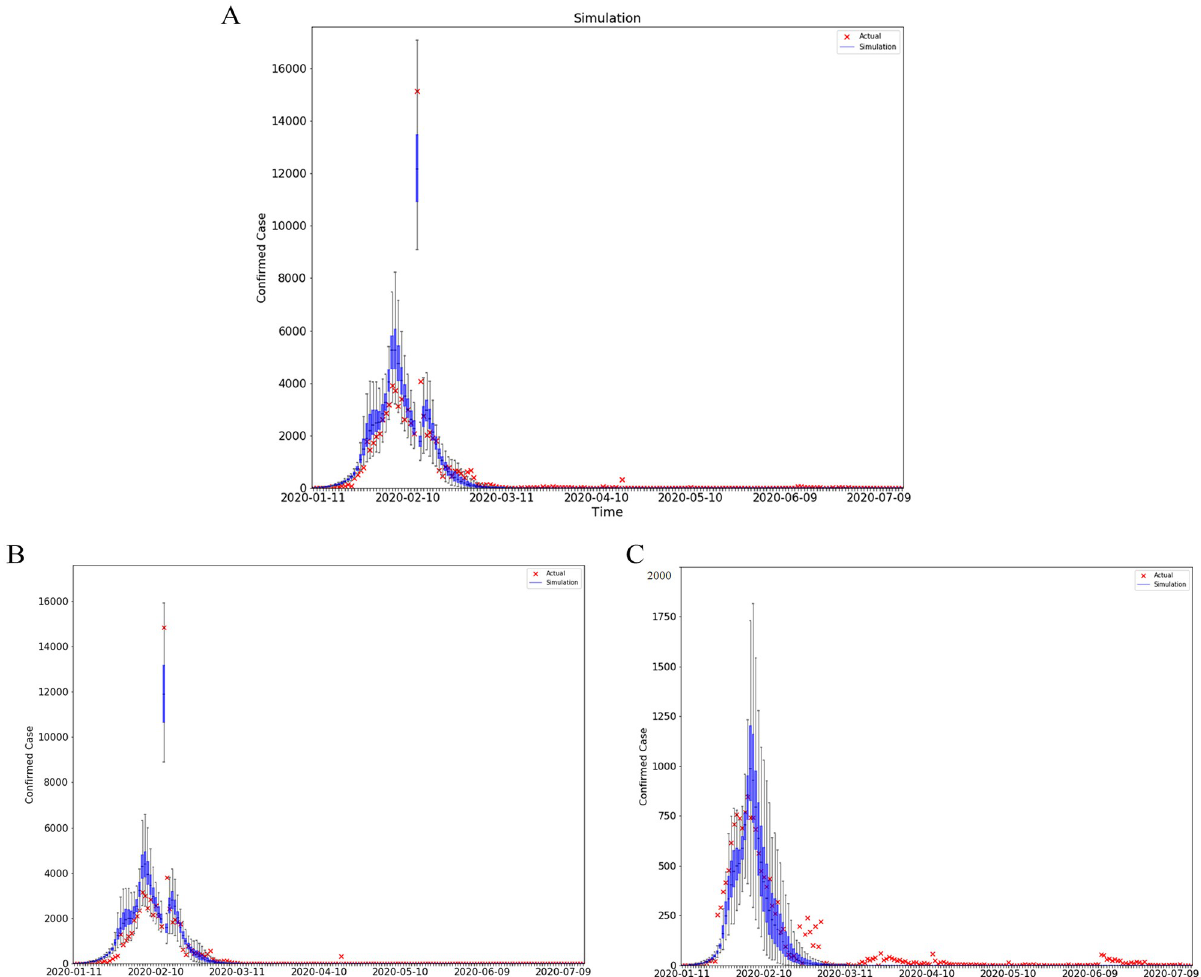
Fig 4. Prediction. These graphs compare the daily official reported number of cases to the simulated ones from 200 simulations using the fully- estimated model in all cities (A), Hubei province(AB), cities outside hubei province (C) from Jan 10,2020 to July 15,2020. The orange x deontes the number of daily reported cases. The blue box and whiskers show the median, interquartile range(IQR), and 1.5IQR derived from 200 simulations using the fitting model with parameters estimated from Fig 2. R 2 = 0.86–0.97.